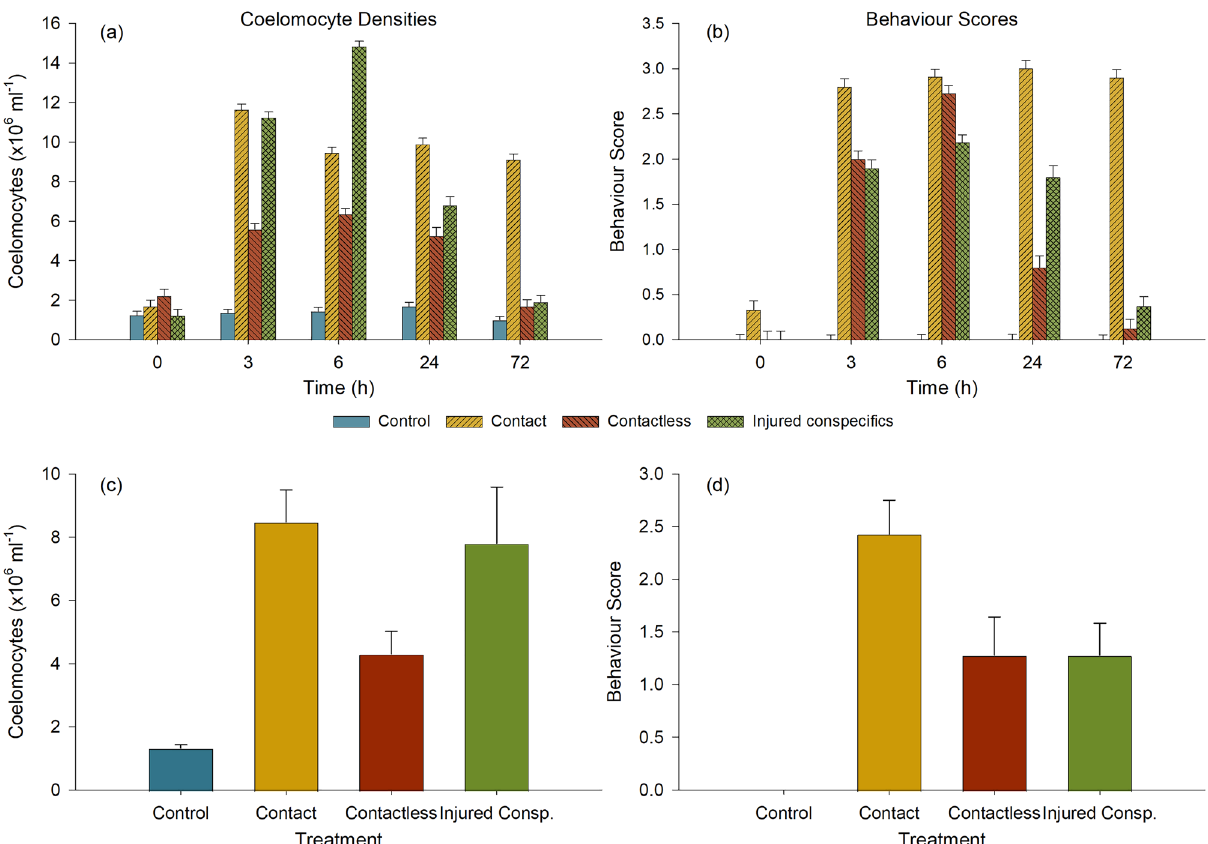
Figure 1. Immune and behavioural responses of Cucumaria frondosa to various treatments, including no stimulus (control), direct contact with the predator (contact), chemical signature of the predator (contactless), and chemical signature of injured conspecific (injured consp.). ( a ) Density of coelomocytes in the Polian vesicle and ( b ) corresponding behavioural score over 72-h exposure. Panels ( c ) and ( d ) illustrate the same metrics integrated over the duration of the experiment (72 h) for each treatment. Values in ( a ) and ( b ) are presented as mean ± S.E. ( n = 3–9) and values in ( c ) and ( d ) are presented as mean ± 95% CI ( n =